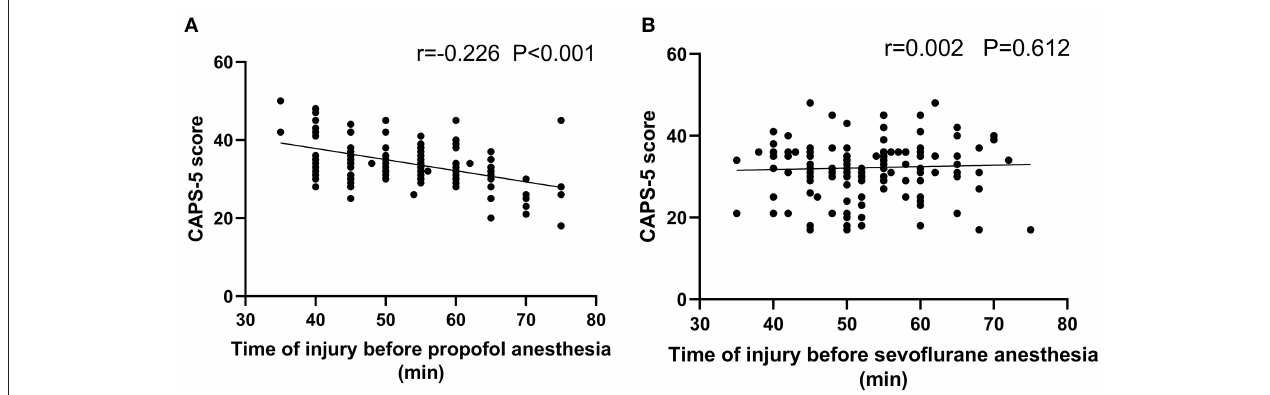
FIGURE 2 | Correlation analysis for the time from injury to admission and the CAPS-5 score 1 month after surgery. (A) shows the propofol general anesthesia group ( n = 142), and (B) shows the sevoflurane general anesthesia group ( n = 139). Scatter plot (A) shows a significant negative correlation between the time from injury to admission and the CAPS-5 score 1 month after surgery ( r = − 0.226; p < 0.001), and (B) shows no significant correlation between the time from injury to admission and the CAPS-5 score 1 month after surgery ( r = 0.002; p = 0.612).